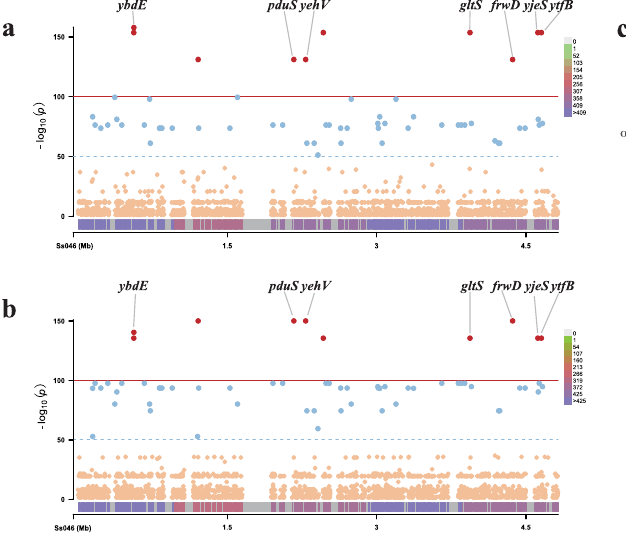
Fig. 5 | TheSNPs identi fi edby a GWAS are associatedwithcef R azi R isolates and the outbreak strains. a and b separately show SNPs identi fi ed by a GWAS asso- ciated with outbreak strains and cef R azi R strains. The red dots represent sig- ni fi cantly associated ( P <1e-100) SNPs, while the blue dots represent SNPs with a P value <1e-50. The thresholds P =1e-100 and P =1e-50 are indicated by a red line and a blue line, respectively. The bottom band shows the density of SNP